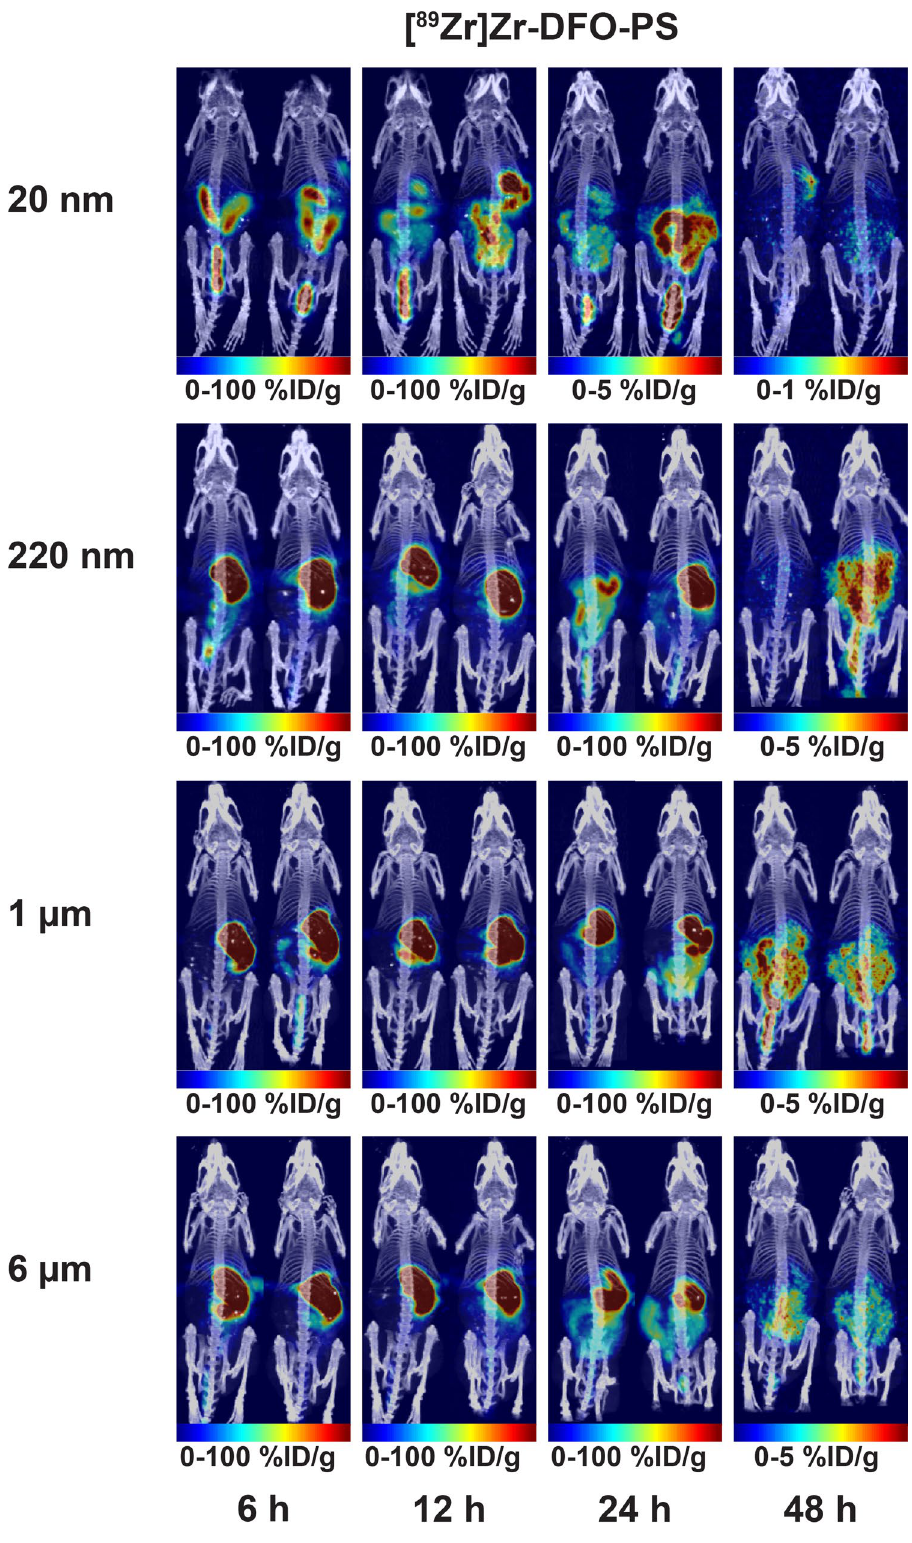
Figure 3. Maximum intensity projection (MIP) PET-CT images of mice that received 1.85 MBq (50 µCi) of [ 89 Zr]Zr-DFO-PS per os . Two mice are shown for each particle size (n = 4 in each cohort). See Fig. S1 for transverse, coronal, and sagittal slices of the sections with the highest activity